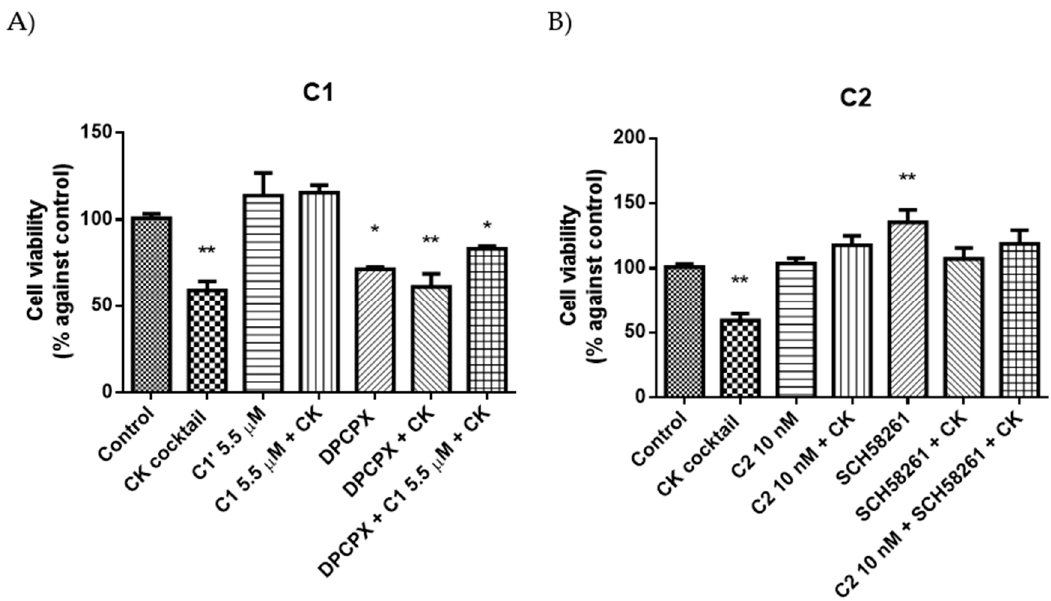
Figure 8. Protective ( A ) and restoring ( B ) effects of C 1 and C 2 , respectively, in presence or absence of A 1 AR (DPCPX) or A 2A AR (SCH58261) antagonists in presence or in absence of CK. Percentage of cell viability after treatments. Results represent the average of 3–5 independent experiments. * p < 0.05, ** p < 0.01 of treated cells against control.